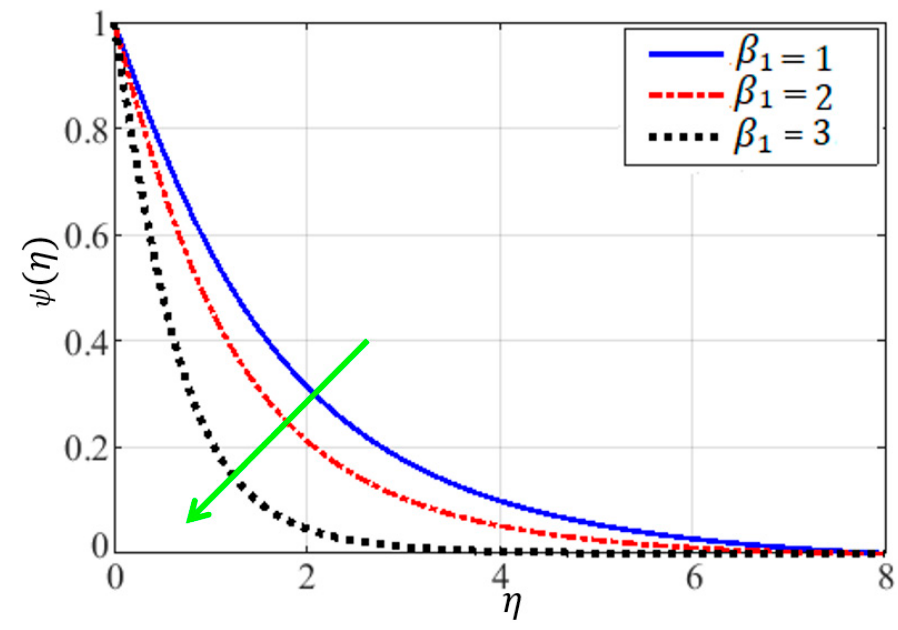
Figure 18. Impact of fl uid parameter on microorganism density fi eld.